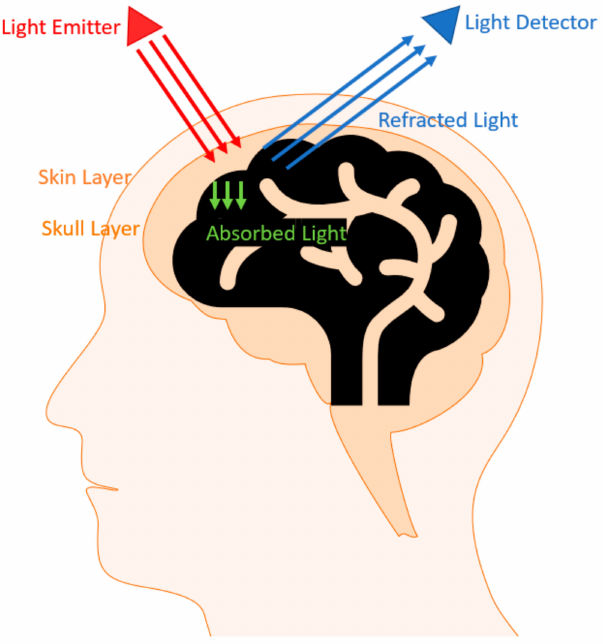
Figure 14. Schematic diagram showing the non-uniform spacing between skull and brain owing to different composition of